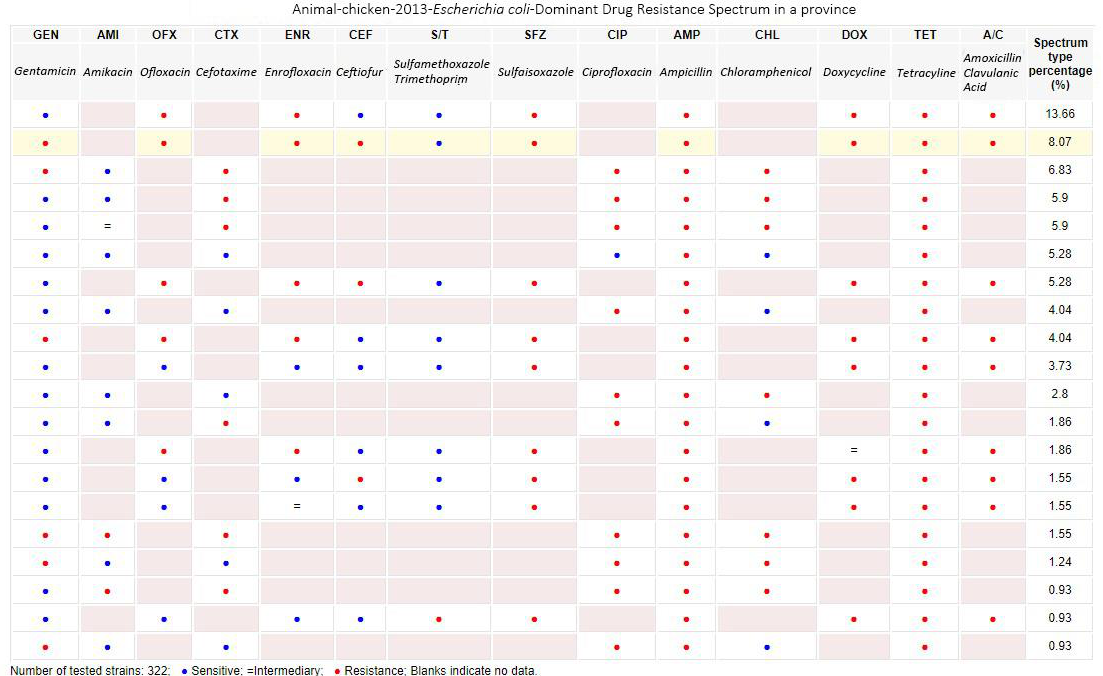
Figure 5. Multiple drugs query ( sample data ) .